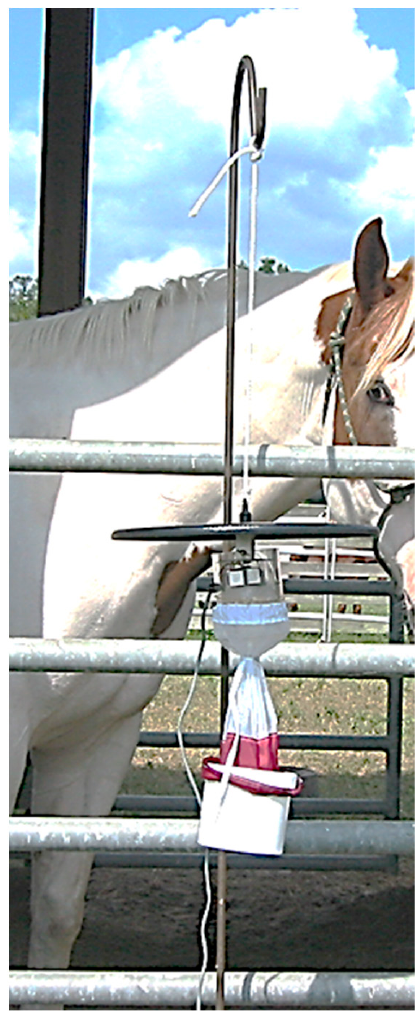
Figure 2. CDC 1012 trap suspended from a metal shepherd’s hook 1 m from the gate of a 3 × 3 m stall. A 6.3 volt light that acts as a visual attractant was eliminated to decrease the number of attractive variables associated with the trap. An in-line fan powered by a 6 volt motorcycle battery, recharged daily, created a suction to capture mosquitoes attracted to the top entrance of the trap beneath the lid and blow them down into a polypropylene collection container with a screened bottom. Unless otherwise stated, in the following studies, carbon dioxide (CO 2 ) was supplied by compressed gas cylinders at a regulated rate of 500 mL/min through a Nalgene line that was attached with rubber bands to the side of the trap. The CO 2 was released near the top entrance of the trap beneath the lid and directly above the level of the in-line